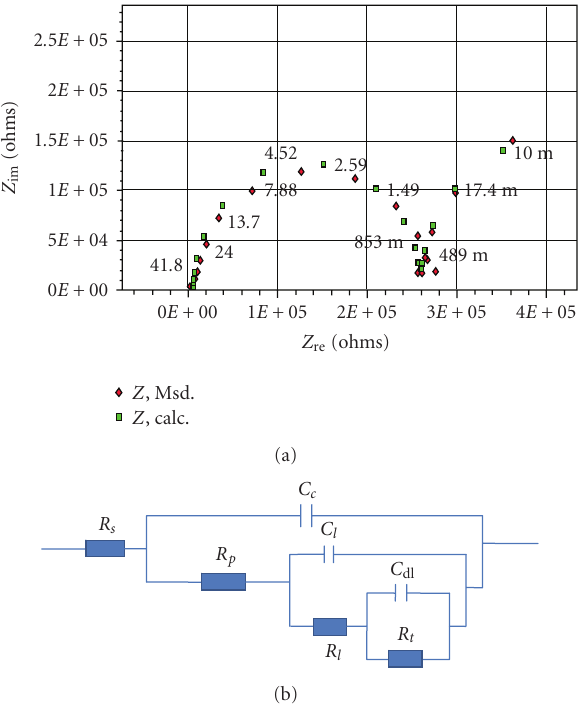
Figure 5: EIS Nyquist graph, equivalent circuit, and imitation result after 1680-hour